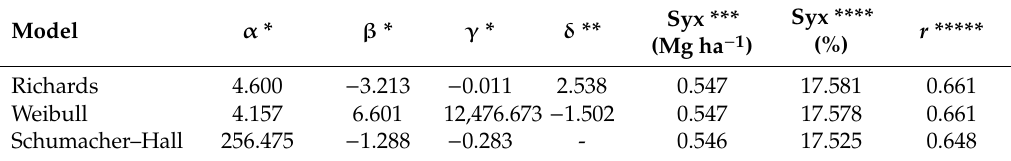
Figure 2. Dispersion of estimated value by observed value, dispersion of residues, and distribution in error classes obtained for the biomass adjustments (Mg ha − 1 ) using non-linear models, where ( a – c ) refer to the Richards model, ( d – f ) to the Weibull model, and ( g – i ) to the Schumacher–Hall model. Table 6. Statistical parameters of the non-linear models obtained in the adjustment of the amount of nitrogen in the eucalypt stand.